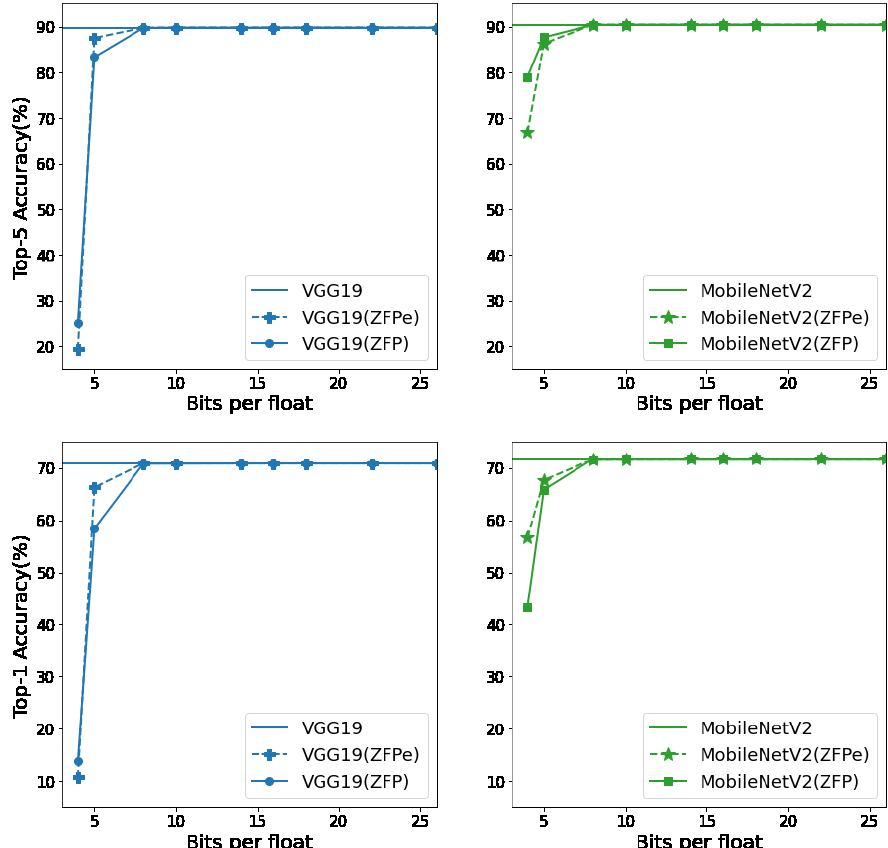
Figure 8. Top-5 and top-1 accuracy of the original and compressed VGG19 and